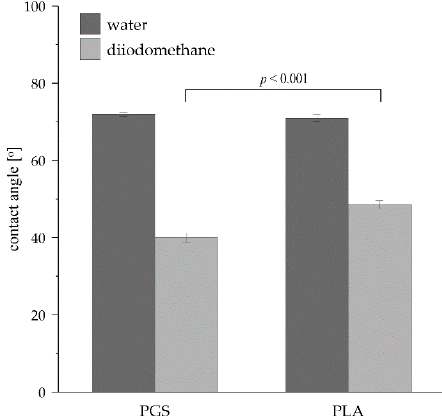
Figure 3. The values of water and diiodomethane contact angles measured for PGS and PLA applied for scaffold preparation. The p values over brackets were determined according to the student’s t -test. Table 1. The values of SFE and density estimated for studied constructs made of PGS and PLA.